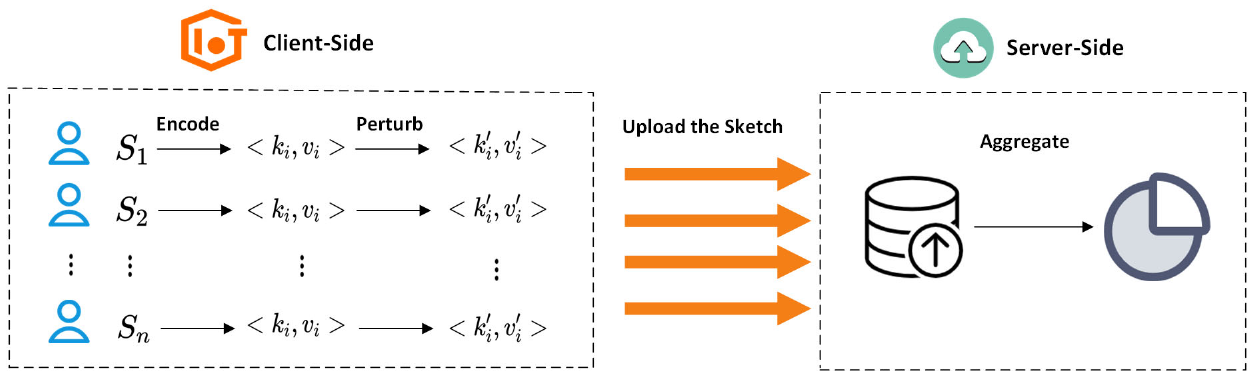
Figure 2. System architecture figure.